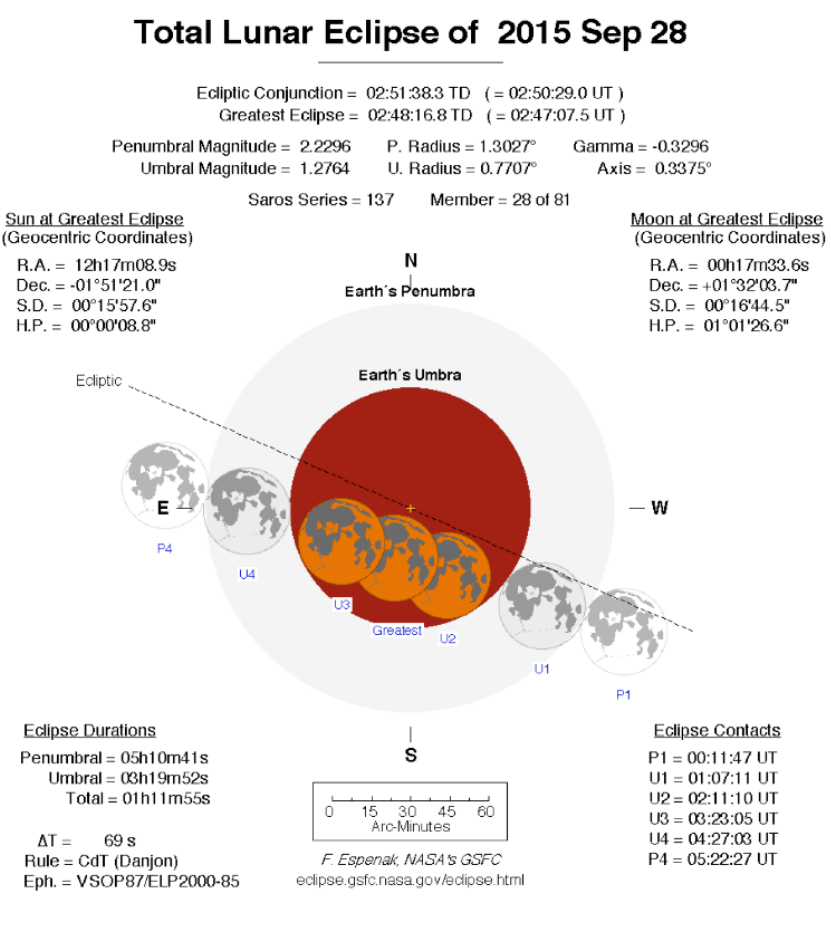
Figure 1. Total lunar eclipse calculation by Fred Espenak, NASA/GSFC.